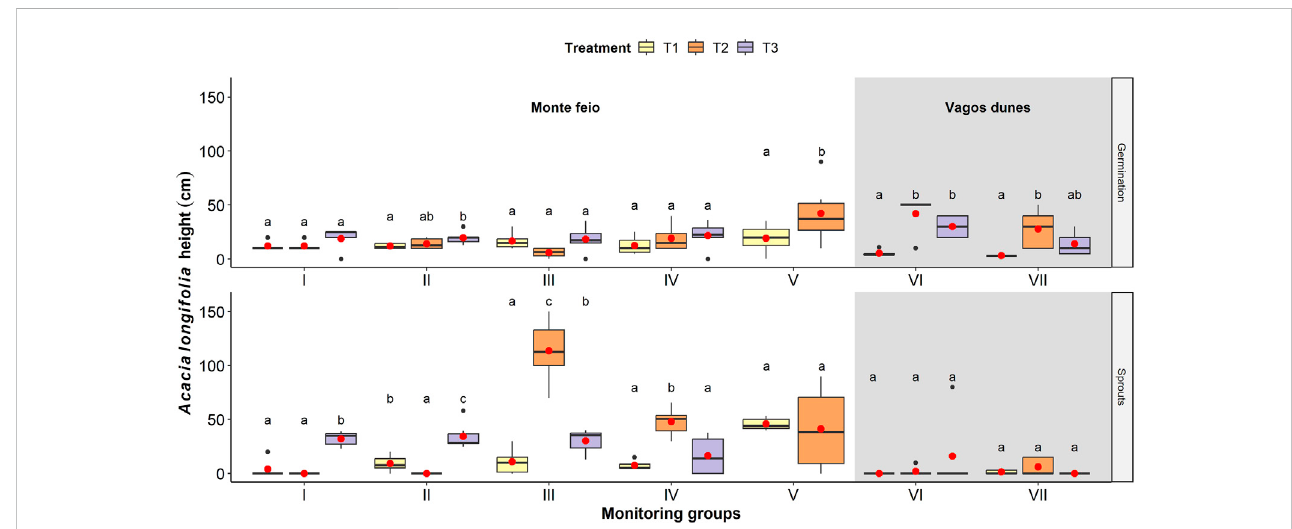
FIGURE 3 Acacialongifolia germination(left)andsprouts(right)dominantheightaftertreatments(T1,T2,andT3)ondifferentmonitoringgroups.Monitoringgroup V has only two treatments (T1 and T2). Letters above whiskers show results of Tukey post-hoc test. For details on the boxplots, see Figure 2.